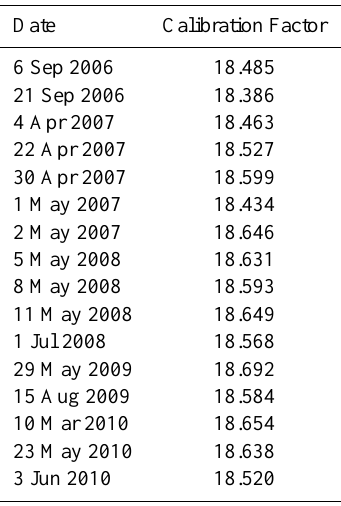
Table 1. List of selected calibration quality clear days from Septem- ber 2006 until the end of August 2010 with their calibration factor. The mean calibration factor is calculated from these